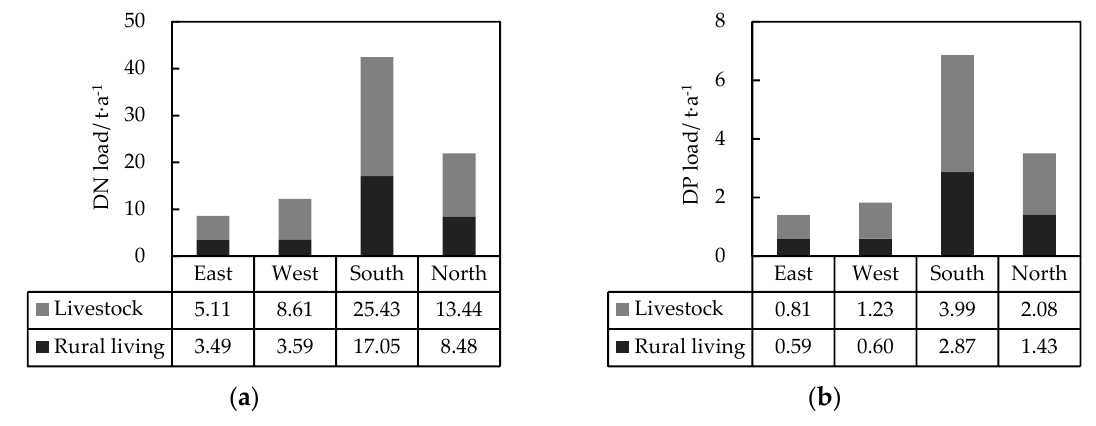
Figure 8. ( a ) DN and ( b ) DP loads discharged into Lake Chenghai from livestock and the rural population.